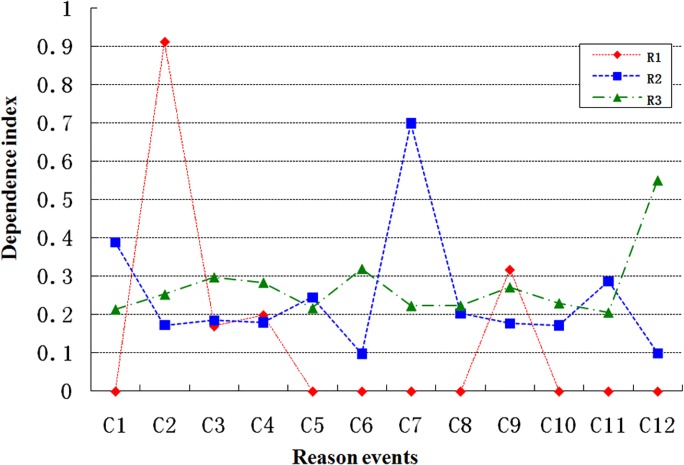
Dependence index map.